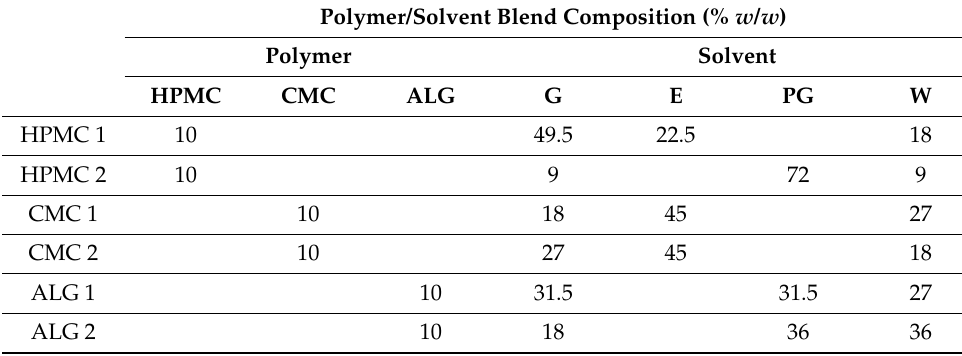
Table 1. Composition of polymer/solvent intramammary